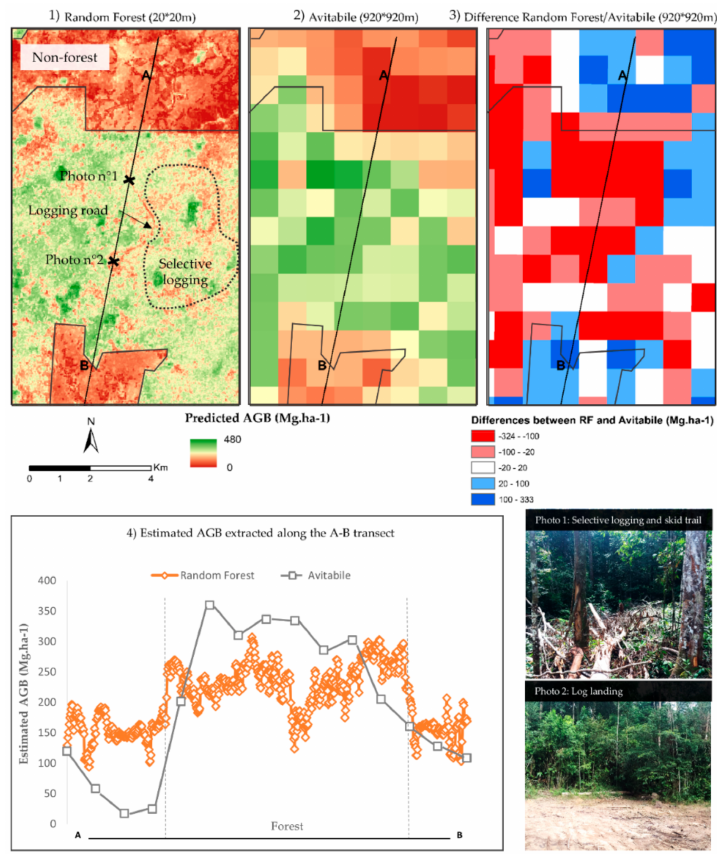
Figure 7. Comparison of AGB estimations, Random Forest, Avitabile [23] and the difference map (1–3 respectively) in a selected zone representing the transition between non-forest to forest area (see Figure 1 for precise location in Paragominas). The selective logging area and the logging road were validated during the field